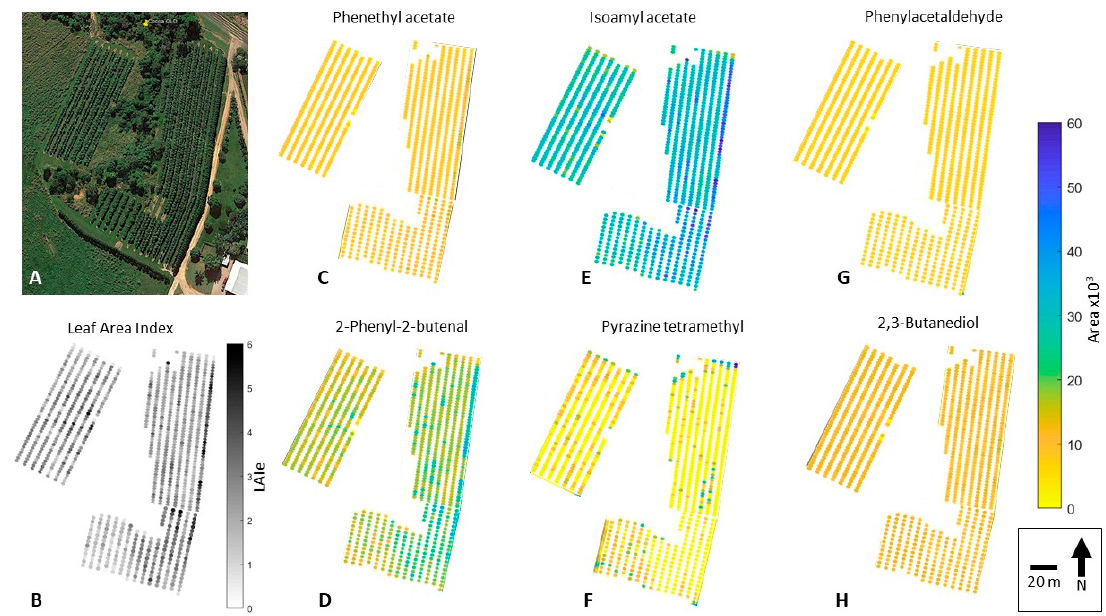
Figure 8. Original aerial image obtained from Google Map Pro ( A ), and plant-by-plant mapping of effective leaf area indexes (LAI e ) ( B ) and aroma profiles for phenethyl acetate (honey/floral/yeasty/cocoa) ( C ); 2-phenyl-2-butenal (sweet/cocoa/nutty/beany) ( D ); isoamyl acetate (banana/fruity) ( E ); pyrazine tetramethyl (roasted/cocoa/coffee/nutty/earthy) ( F ); phenylacetaldehyde (honey/rose/cocoa) ( G ); and 2,3-butanediol (cocoa butter/creamy) ( H ).